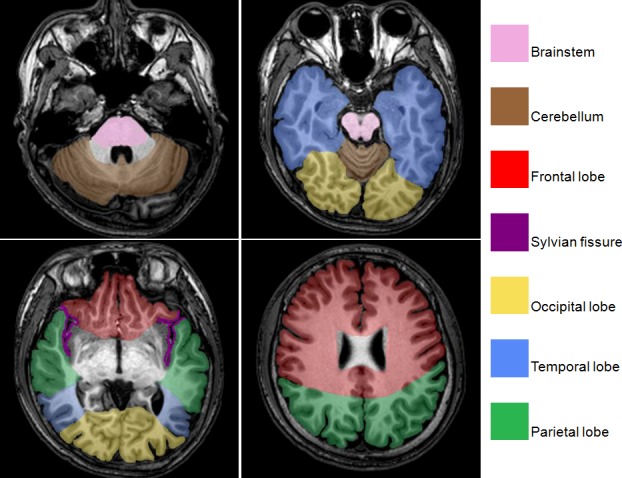
An MRI performed on a healthy subject using spin-echo T1-weighted imaging.We obtained axial slices of the normal brain. The anatomical structures of the subarachnoid space were labeled according to the following method. The subarachnoid area of each cerebral hemisphere was divided into 5 regions (frontal lobe, temporal lobe, occipital lobe, parietal lobe, and Sylvian fissure), and the subarachnoid areas of the cerebellum and the brainstem were divided into two relatively independent regions. Then, the number of regions, ranging from 0 to 12, of the subarachnoid area of the entire brain, excluding the ventricular system, was determined.